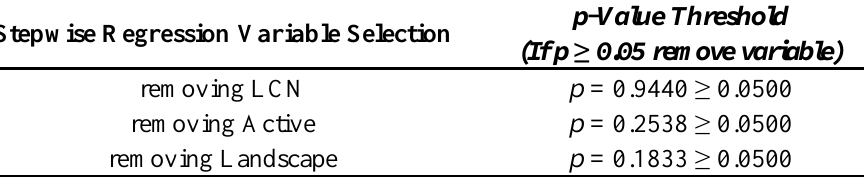
Table 5. Stepwise regression variable selection